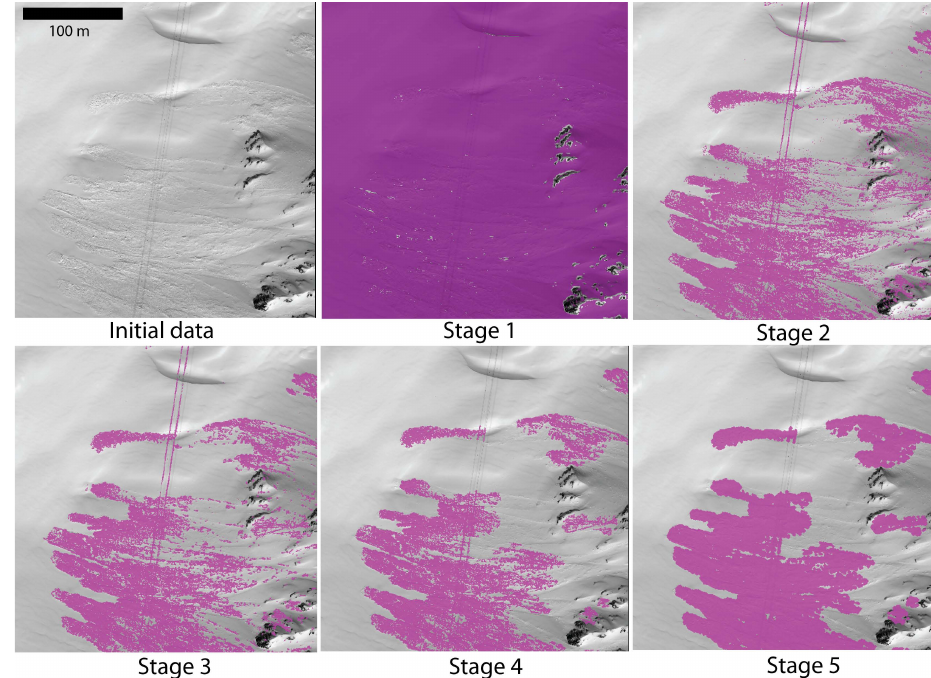
Fig. 5. General processing steps and staged results for avalanche deposit identification in eCognition. The process illustrates the workflow for Leica imagery as reported in Fig. 4. The steps illustrate the progressive segmentation and classification of the image, resulting in an image with only avalanche deposits